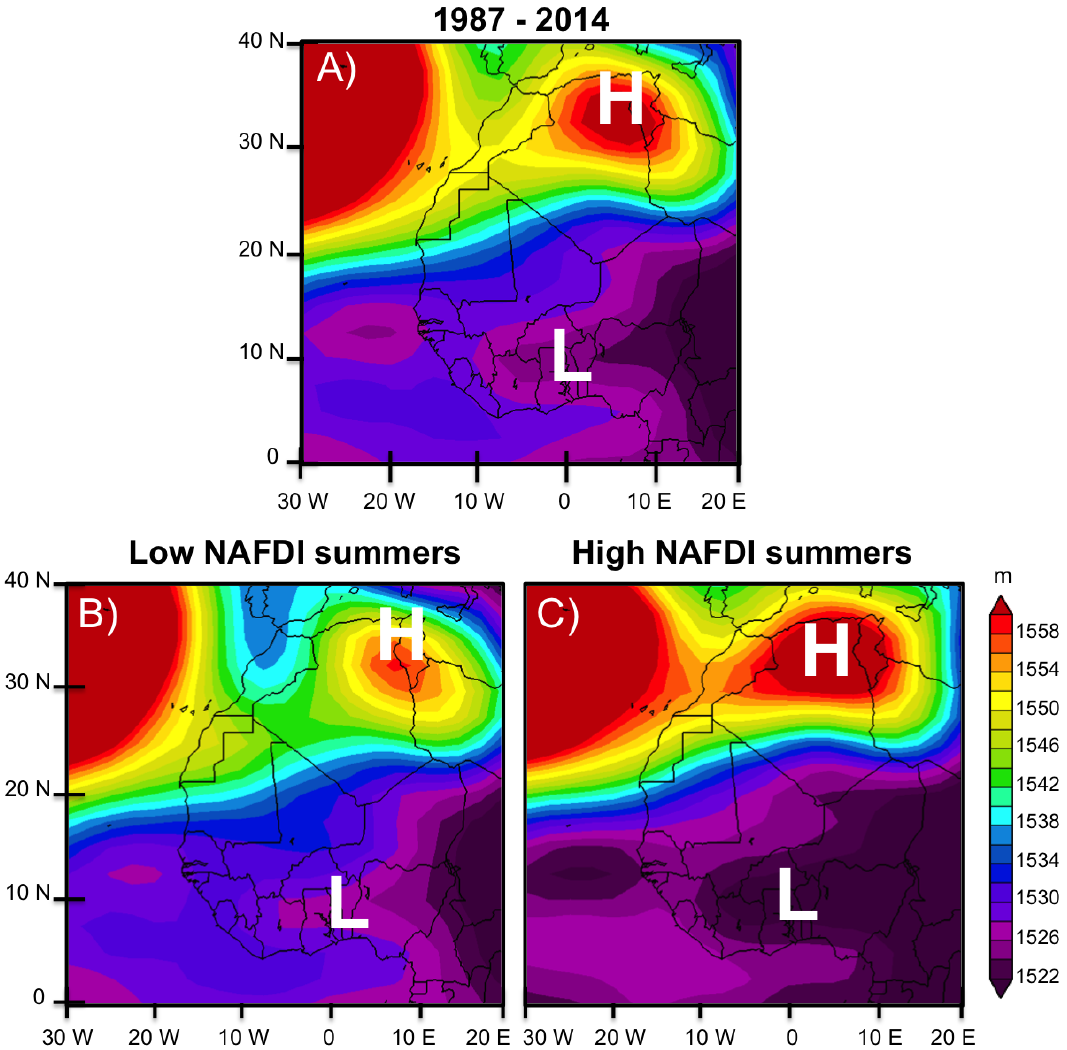
Figure 2. Height of the 850hPa geopotential over North Africa averaged in (a) all summers (August) from 1987 to 2014 and in summers (August) with (b) low NAFDI values (1987, 1996, 1997 and 2006 have − 2.79, − 2.04, − 3.19 and − 1.54, respectively) and (c) high NAFDI values (1988, 2000, 2008 and 2012 have + 0.68, + 0.83, + 1.01 and + 2.29,